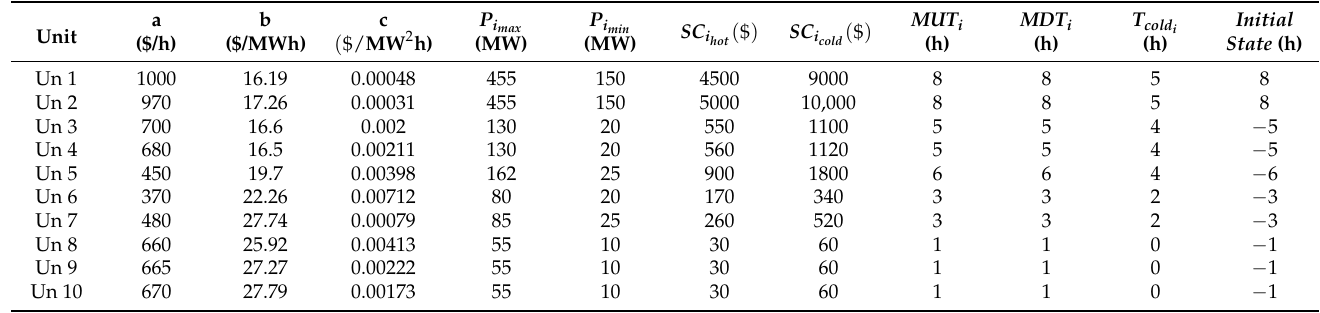
Table 3. The 10-unit system input data